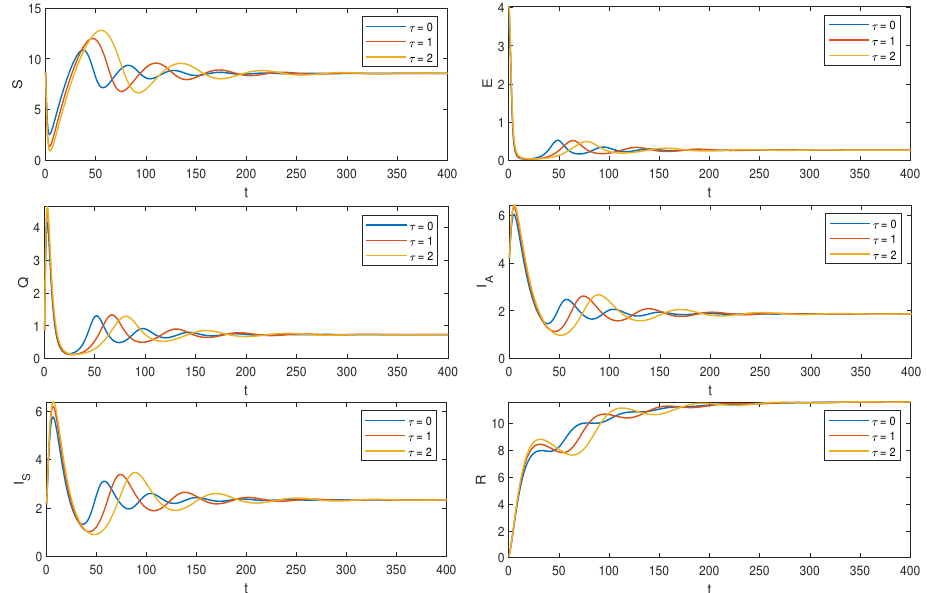
Figure 3. Local asymptotic stability of the endemic equilibrium point when τ is different. The biological significance of the parameter m is the epidemic control measures imposed on the susceptible population S . γ is the isolation rate (the efficiency of detecting infected individuals); i.e., the greater the control input, the greater the values of m and γ , and the better the epidemic control—the faster convergence to zero for asymptomatic and symptomatic infected individuals. See Figures 4 and 5.